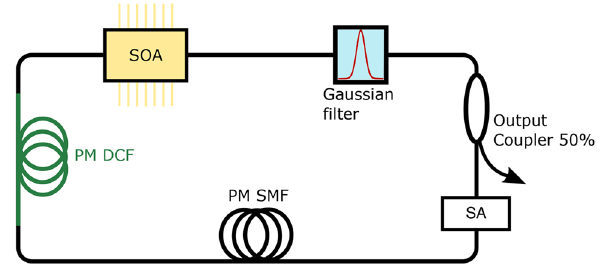
Figure 1. Schematics of a SOA-based fiber laser